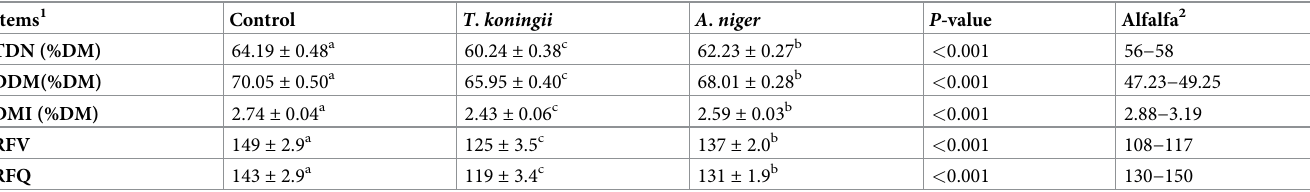
Table 2. Feeding value of fermentation products.